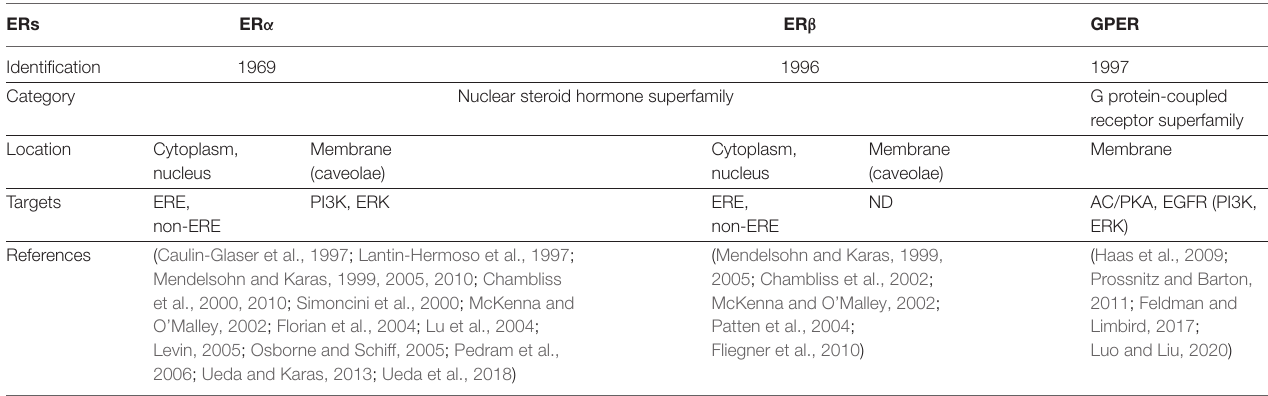
TABLE 1 | Characteristics of